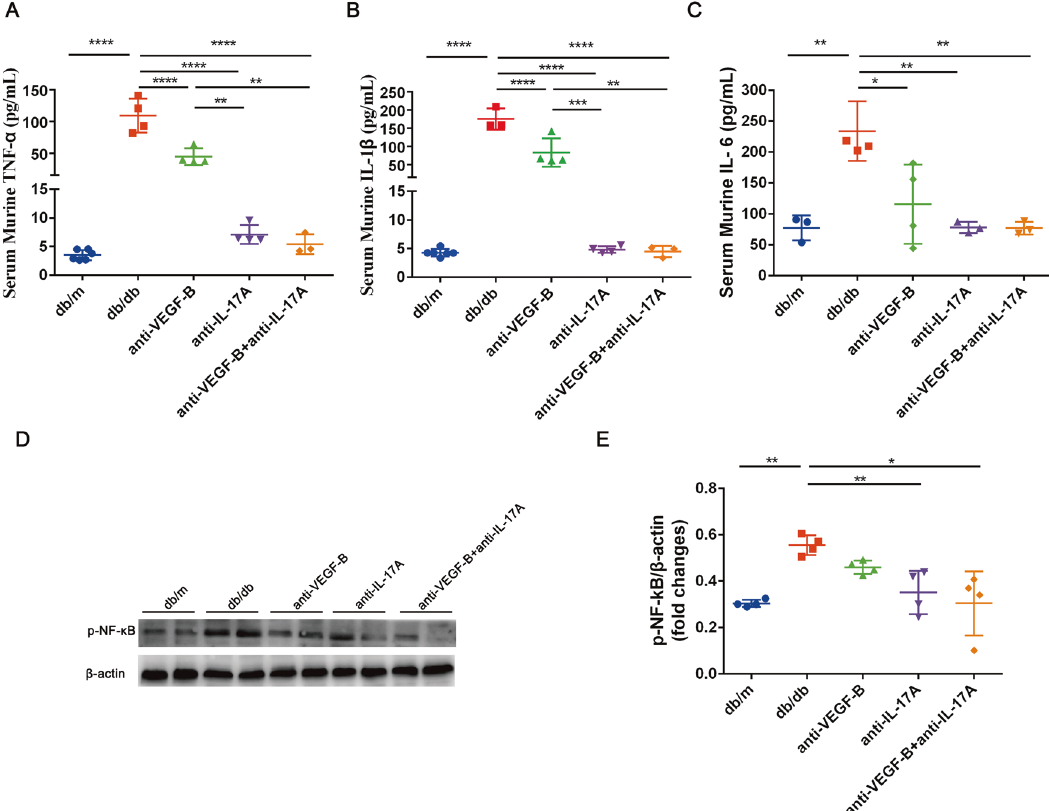
Fig. 5 Pharmacological neutralization of VEGF-B and IL-17A reduced the renal in fl ammation in DKD mouse model. A The content of TNF- α in serum was measured by ELISA. B The content of IL-1 β in serum was measured by ELISA. C The content of IL-6 in serum was measured by ELISA. D Western blot analysis of NF- κ B p65 in all groups of mice. E Quantitative analysis of NF- κ B p65 protein expression. The data were presented as means ± SD (for ELISA assay, n = 3 – 6 mice in each group; for the analysis of NF- κ B p65, n = 2 mice in each group, data were representative of two independent experiments, **** P < 0.0001, ** P < 0.01, * P < 0.05). The statistical signi fi cance was analyzed by one-way ANOVA with Tukey ’ s multiple-comparisons